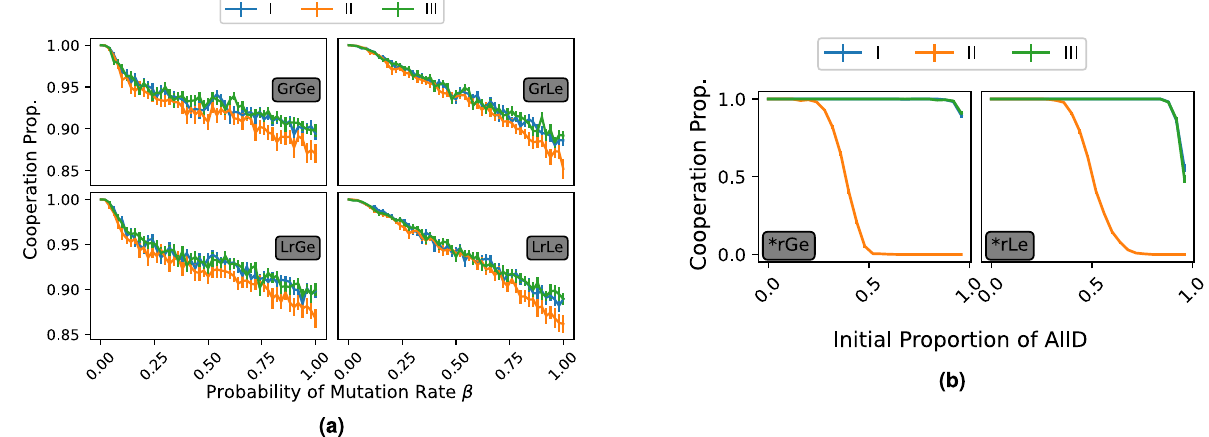
Figure 4. The effect of the likelihood of an AllD mutant entry and the initial proportion of AllD on cooperation. ( a ) As the rate at which AllD agents are introduced into the population increases, the level of cooperation decreases. Under local evolution, we see that the decrease is generally linear. Under global evolution, after the initial drop in cooperation for small β values, for 0.15 < β < 1 we see a smooth decline in cooperation as the rate of mutations increases. ( b ) The differential impact of the initial proportion of AllD agents on the success of social norms in maintaining universal cooperation. Group II strategies lose their dominance starting from 25% of AllD players at the outset in global evolution (left) and from 40% in local evolution (right). In contrast, groups I and III maintain their dominance even if a large majority of the population initially consist of AllD